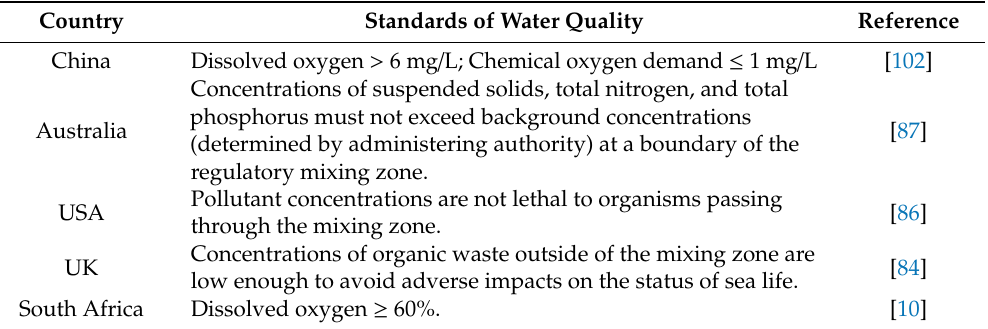
Table 4. List of water quality standards of regulatory mixing zone (receiving environment) in di ff erent countries and regions.